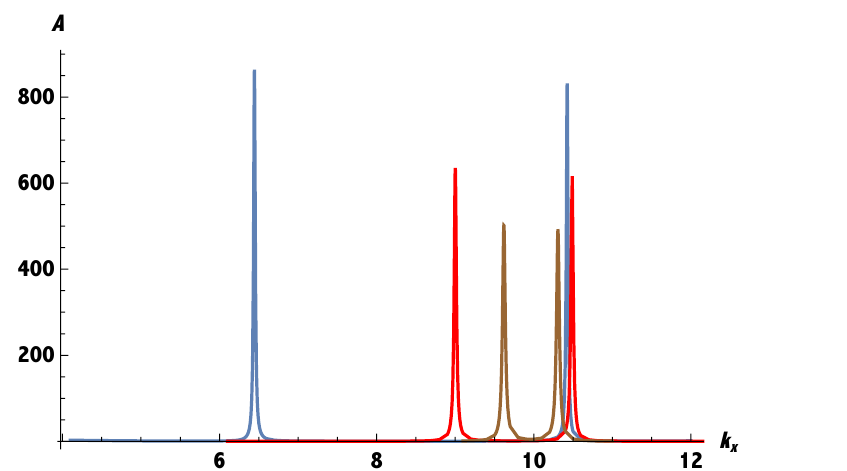
Figure 5. Plot of spectral function A vs. k x with k y = 0 with different strengths of ionic lattices a i = 0 (blue), 0.1 (red), 0.2